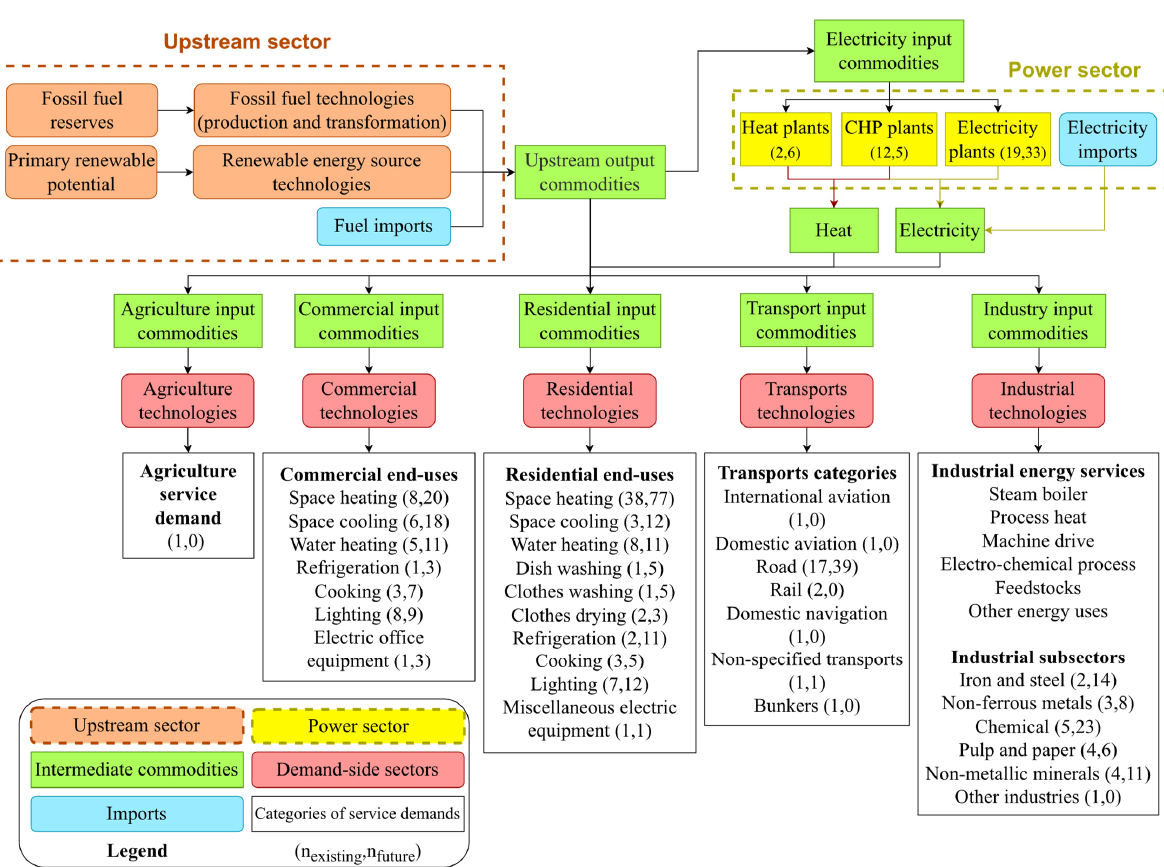
Figure 3. Schematic structure of the TEMOA-Italy reference energy system, connections between the different sectors and number of the described technologies.